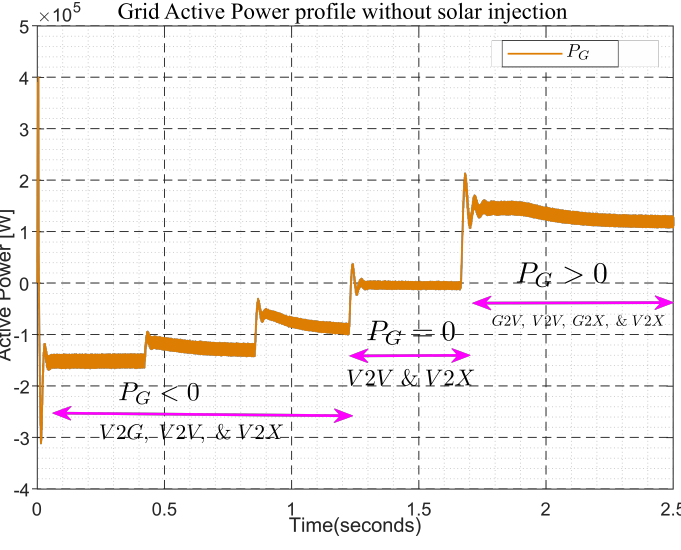
Figure 19. Grid active power profile.